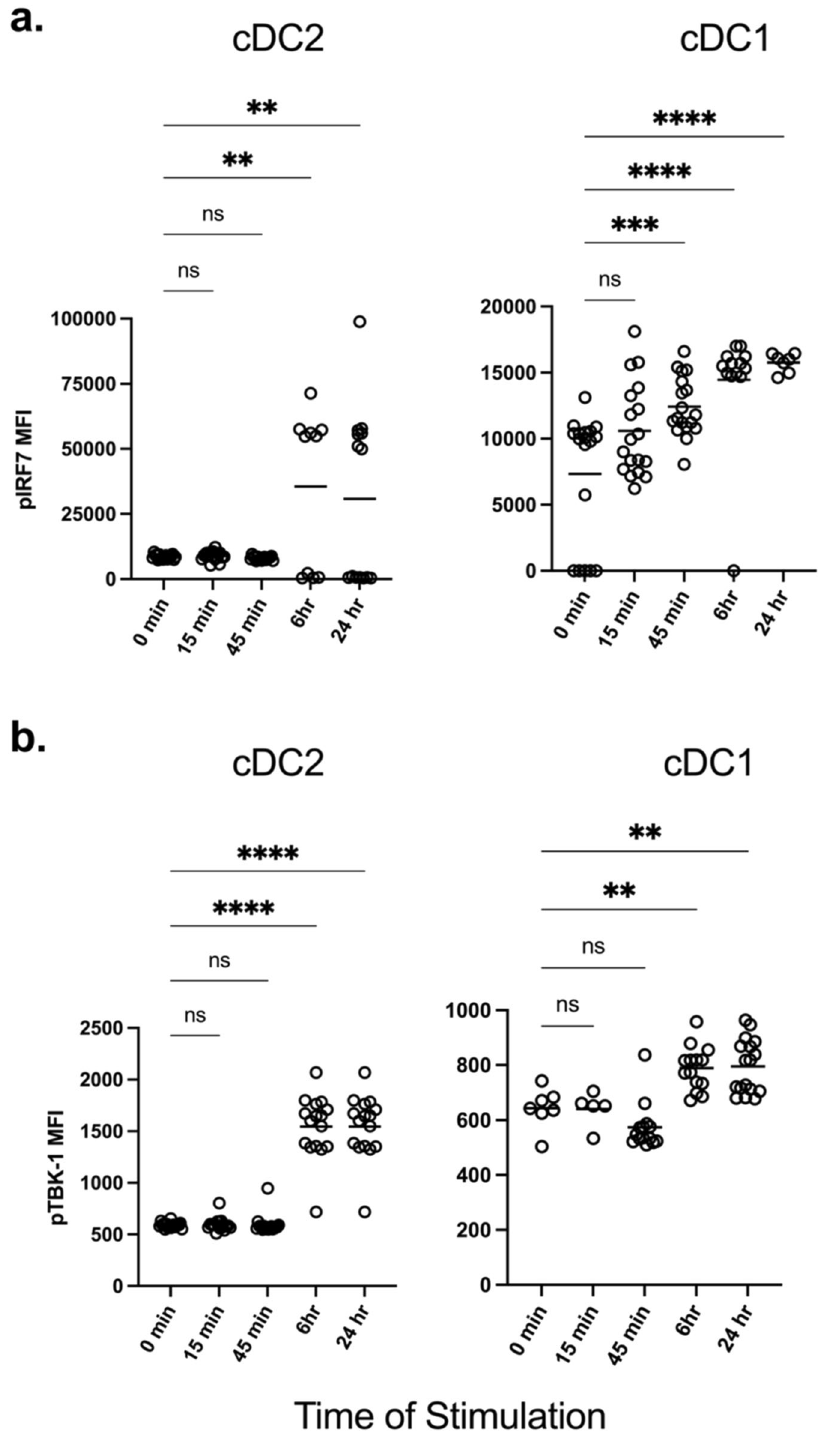
Fig. 2 IRF7/TBK-1 axis is important for eLNP-induced innate response. Human PBMCs from healthy donors were either stimulated with 15 μ g/mL (total lipids, or ~7.5 μ g/mL ionizable lipid) eLNP for 15 min, 45 min, 6, or 24 h. For unstimulated and control conditions refer to Fig. 1. Cells were permeabilized, fi xed, and stained for ( a ) phosphorylated interferon response factor 7 (IRF7) transcription factor or ( b ) phosphorylated TBK-1. After gating on monocyte and DC subsets, the geometric mean intensity (MFI) was measured using phos fl ow cytometry. Each individual circle represents one individual subject. * P < 0.05, ** P < 0.01, *** P < 0.001, and **** P < 0.0001 by one-way old p = 0.0086), IL-2 (young = 0.0015, old p = 0.0031), and IL- 12 (old p = 0.0151) (Fig. 5b). Namely, we saw signi fi cantly more cytokine production in older vs younger adults in CD40L maturation markers are signi fi cantly lower in older subjects ( p = 0.0061), IL-2 ( p = 0.0515), and IL12p70 ( p = 0.0376). whereas pro-in fl ammatory cytokines are higher.